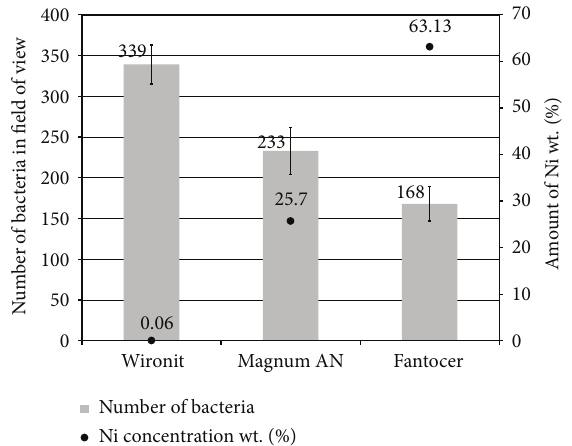
Figure 6: Relationship between the number of bacteria and nickel content in the